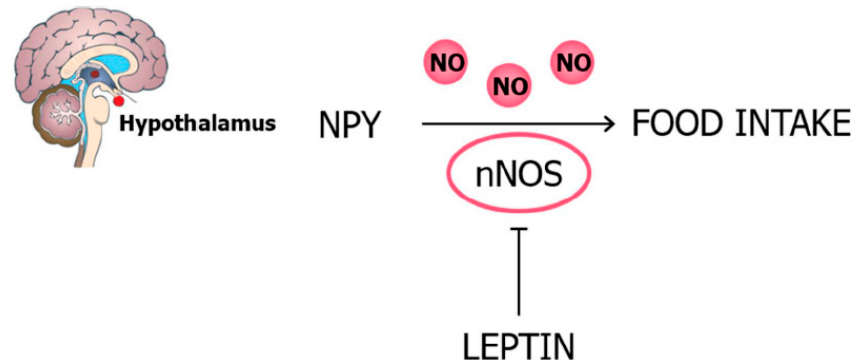
Figure 1. nNOS activity is required for the effects of leptin on food intake. Leptin alters the neuropeptide Y (NPY) effect decreasing nNOS activity by phosphorylation of the hypothalamic neurons of the ARC, DMH, and PMV. ARC, arcuate nucleus; DMH, dorsomedial nucleus of the hypothalamus; nNOS, neuronal nitric oxide synthase; PMV, ventral premammillary nucleus.